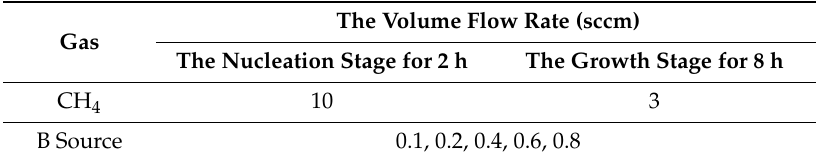
Table 2. Deposition parameters of the variation of B source flow rate.